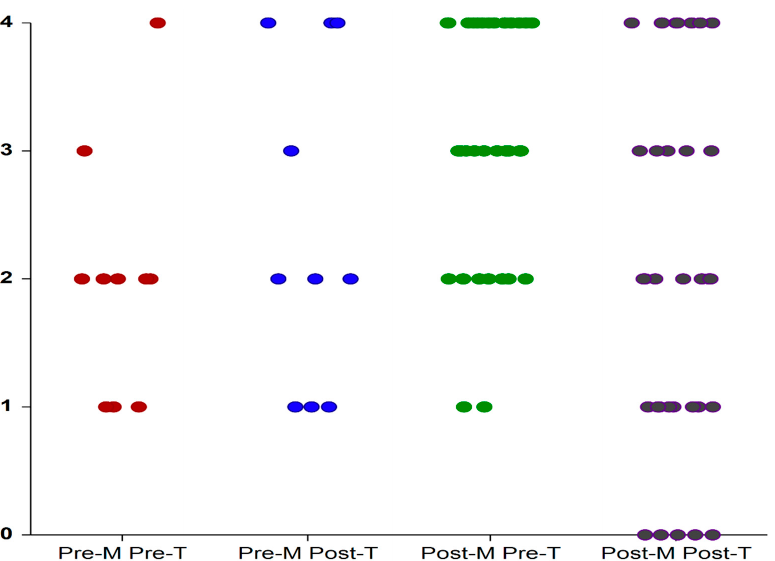
Figure 2. PPIUS values before treatment (Pre-T) and after treatment (Post-T) with local estrogens in patients with OAB symptoms of premenopausal (Pre-M) and post-menopausal (Post-M) onset. Each dot depicts an individual patient. T: treatment; M: menopause.